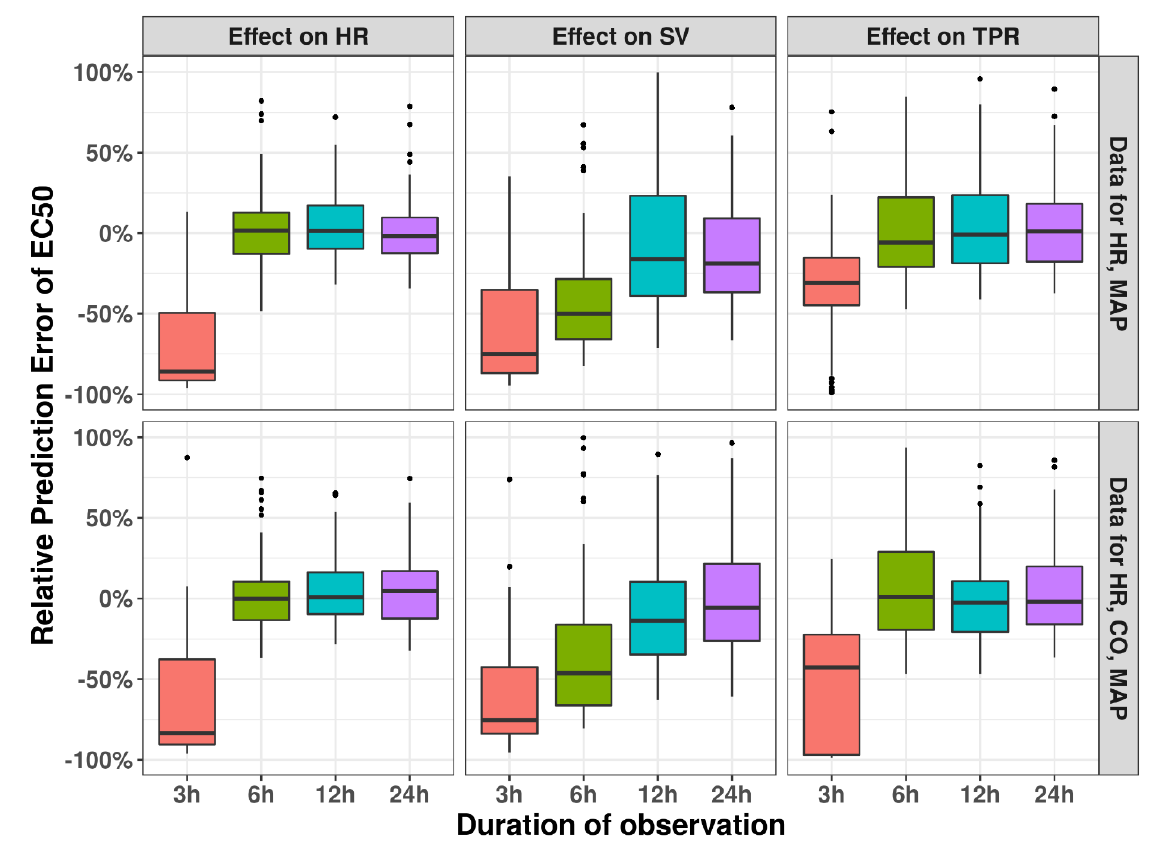
Figure 5. Impact of duration of experimental observations on relative prediction error of drug effect estimate EC 50 . Results from simulation and re-estimation analyses using either observations of HR and MAP or observations of HR, CO, and MAP within 3 h, 6 h, 12 h, and 24 h, while Emax was fixed as −1 and EC 50 was fixed as 100 ug/mL in the original model.